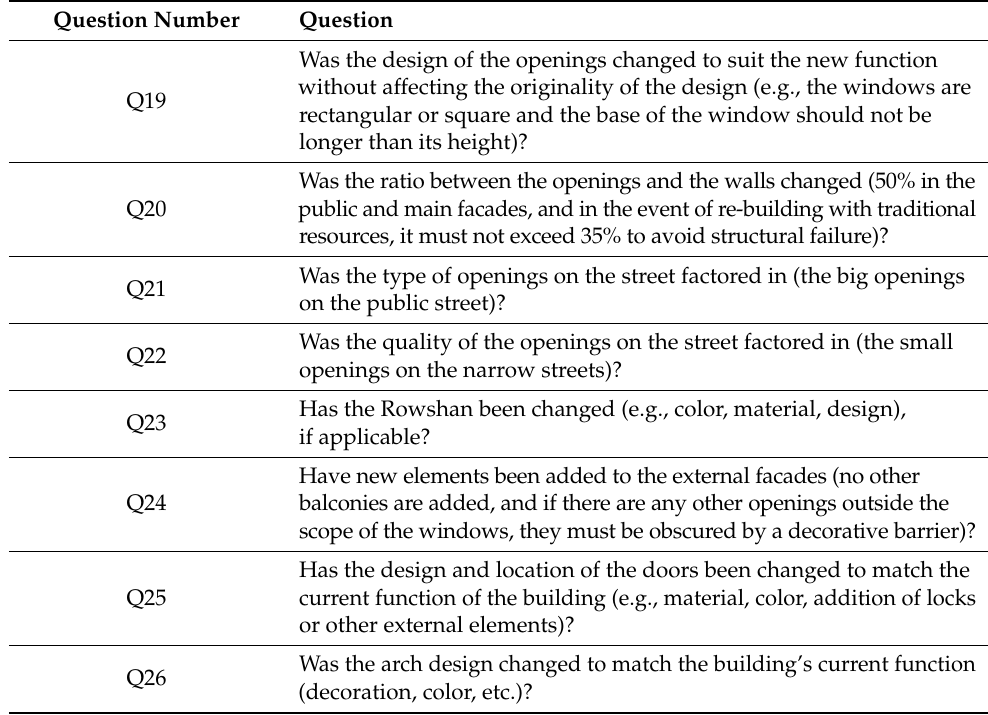
Table 5. Architectural design questions